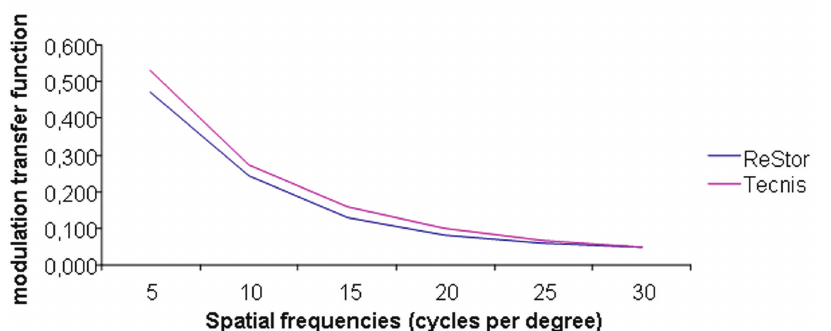
Figure 3 - The modulation transfer function (MTF) curve analyzed for a 5 mm pupil diameter of the IOL groups at different spatial frequencies. The MTF shows the contrast transferred at different spatial frequencies. The aspheric full diffractive multifocal IOL Tecnis ZM900 performed similar to the spherical apodized diffractive multifocal ReSTOR ( p >0.05 at all spatial frequencies